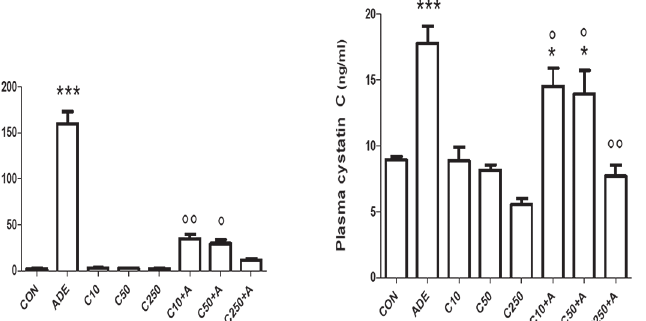
Fig 4. Effect of chrysin treatment on plasma concentrations of indoxyl sulfate and cystatin in control rats and rats treated either singly or concomitantly with either adenine (ADE) or chrysin (C) at doses of 10, 50 or 250 mg/kg. Each column and vertical bar is a mean ± SEM (n = 6).